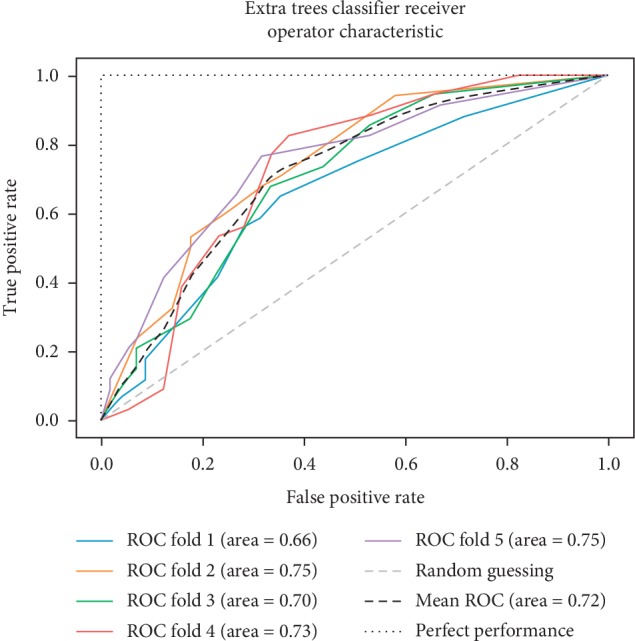
ROC curve for ET.